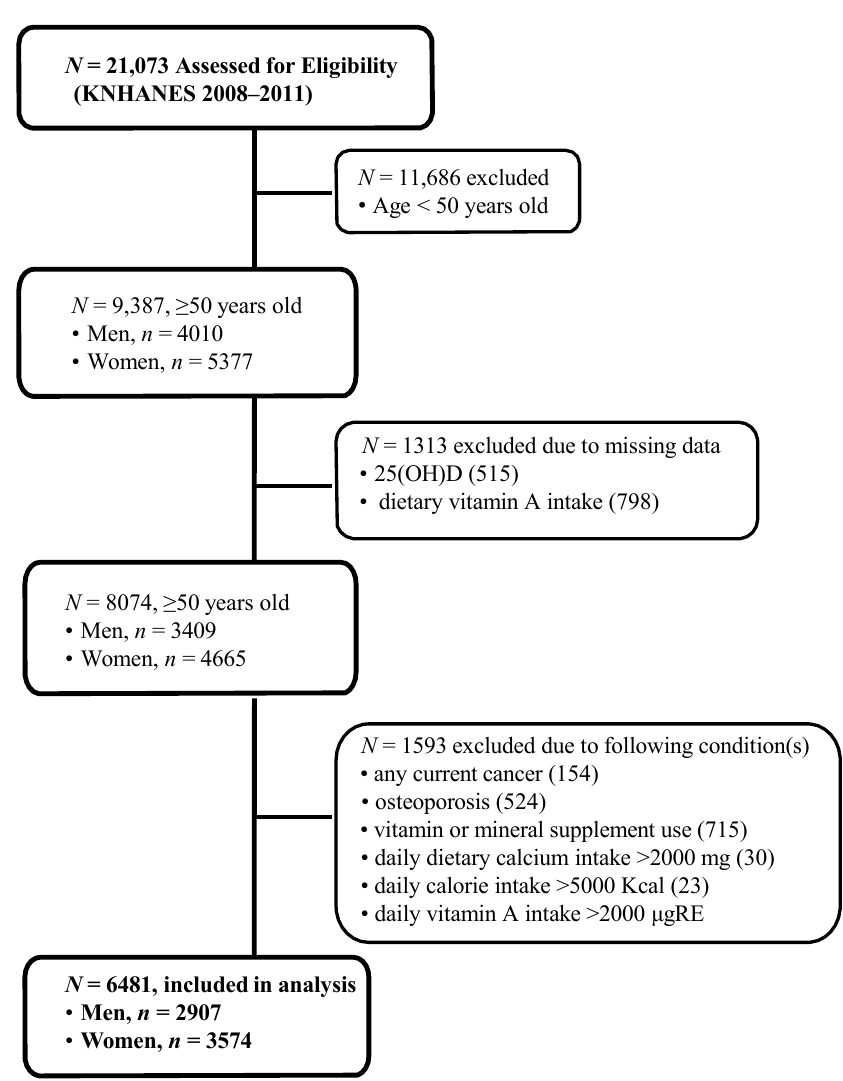
Figure 1. Flow diagram of subject inclusion and exclusion in the Korea National Health and Nutrition Examination Surveys (KNHANES 2008–2011). FRS: Framingham Risk